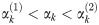
Stochastic oscillations persist outside the deterministic oscillatory regime.The deterministic oscillatory regime is defined by αk(1)<αk<αk(2) for the induction rate αk. (A) At low induction rate αk<αk(1), where the deterministic model predicts excitable dynamics, the stochastic dynamics are oscillatory. The oscillations arise from repeated noise-induced excitations. (B) At high induction rate αk>αk(2), where the deterministic model predicts mono-stable dynamics, the stochastic dynamics are also oscillatory. The oscillations here arise because noise prevents damping to the mono-stable state (see the deterministic curves in the right panels). The effect is much stronger for the native circuit (notice that the left panel is 15 times outside the deterministically oscillatory regime) because, unlike in the SynEx circuit, one of the species, ComS, is at low copy number and therefore subject to significant intrinsic noise. The deterministic model is given in Eqs 6 and 7, while the stochastic model is given in Eqs 1–5. In A, the deterministic initial conditions are n¯0=1 ComK molecules and m¯0=100 ComS molecules (native), and n¯0=0 ComK molecules and m¯0=0 MecA molecules (SynEx). In B, the deterministic initial conditions are n¯0=5 ComK molecules and m¯0=1 ComS molecules (native), and n¯0=0 ComK molecules and m¯0=0 MecA molecules (SynEx). In the excitable regime (A), the initial conditions are chosen to demonstrate the single, transient excitation.